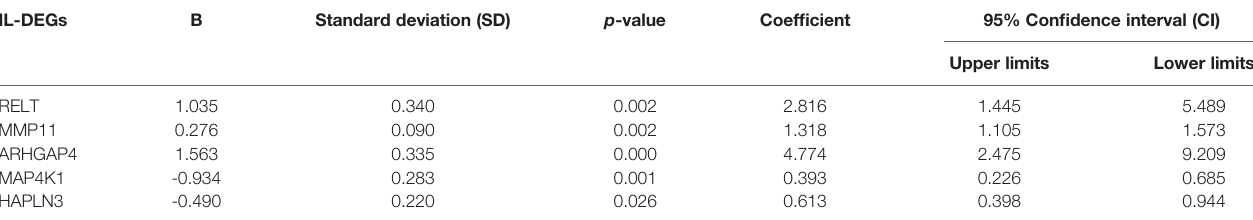
TABLE 2 | Immune landscape-based DEGs (IL-DEGs) included in the formula of the immune landscape-based risk score (ILBRS).